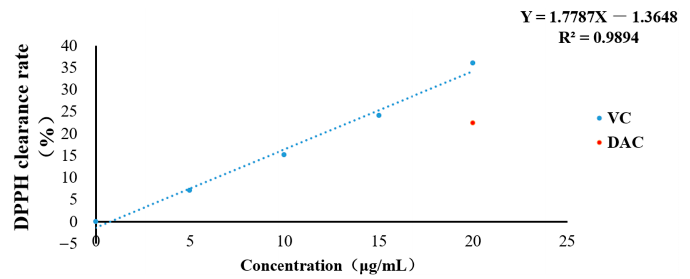
Figure 1. The clearance rate of DPPH.